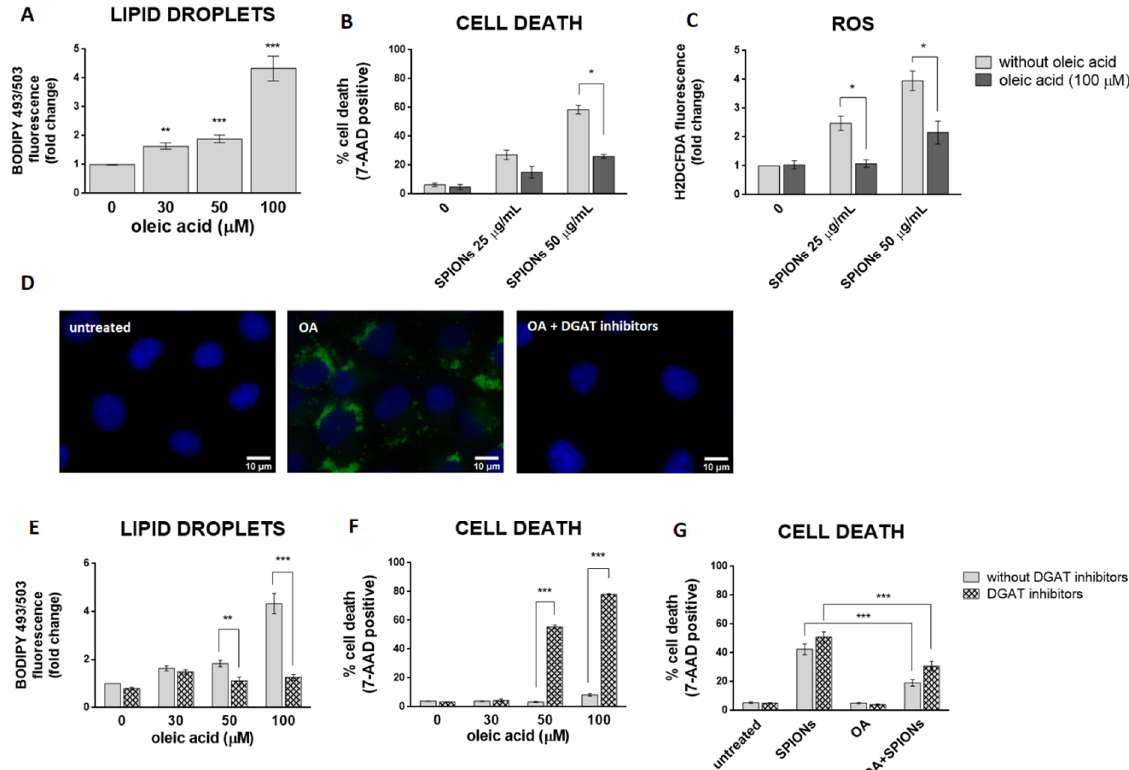
Figure 4. LD formation is not required for OA to inhibit silica-coated SPIONs-induced cell death and oxidative stress. ( A ) HUVEC cells were treated with 30, 50, and 100 µM OA for 24 h and LDs were quantified by flow cytometry, using BODIPY 493/503 staining. ( B , C ) Cells were treated with OA (100 µM) and silica-coated SPIONs (25 and 50 µg/mL) for 24 h. Cell death and ROS were quantified by flow cytometry using 7-AAD ( B ) and CM-H 2 DCFDA ( C ) staining, respectively. ( D ) Cells were treated with 100 µM OA and/or DGAT inhibitors (5 µM T863 and 5 µM PF-06424439) for 24 h. Cells were stained with BODIPY 493/503 and Hoechst 33342 to visualize LD (green) and nuclei (blue), respectively. ( E , F ) HUVEC cells were treated with DGAT inhibitors (5 µM T863 and 5 µM PF-06424439) and OA (30, 50, and 100 µM) for 24 h. LD and cell death were quantified by flow cytometry using BODIPY 493/503 ( E ) and 7-AAD ( F ) staining, respectively. ( G ) HUVEC cells were treated with DGAT inhibitors (5 µM T863 and 5 µM PF-06424439), OA (30 µM), and silica-coated SPIONs (50 µg/mL) for 24 h. Cell death was quantified by flow cytometry using 7-AAD staining. Values on the graphs are means ± SEM of at least three independent experiments; statistically significant differences in mean values are indicated (*, p < 0.05; **, p < 0.01; ***, p < 0.001; one-way ANOVA with Tukey post hoc test).